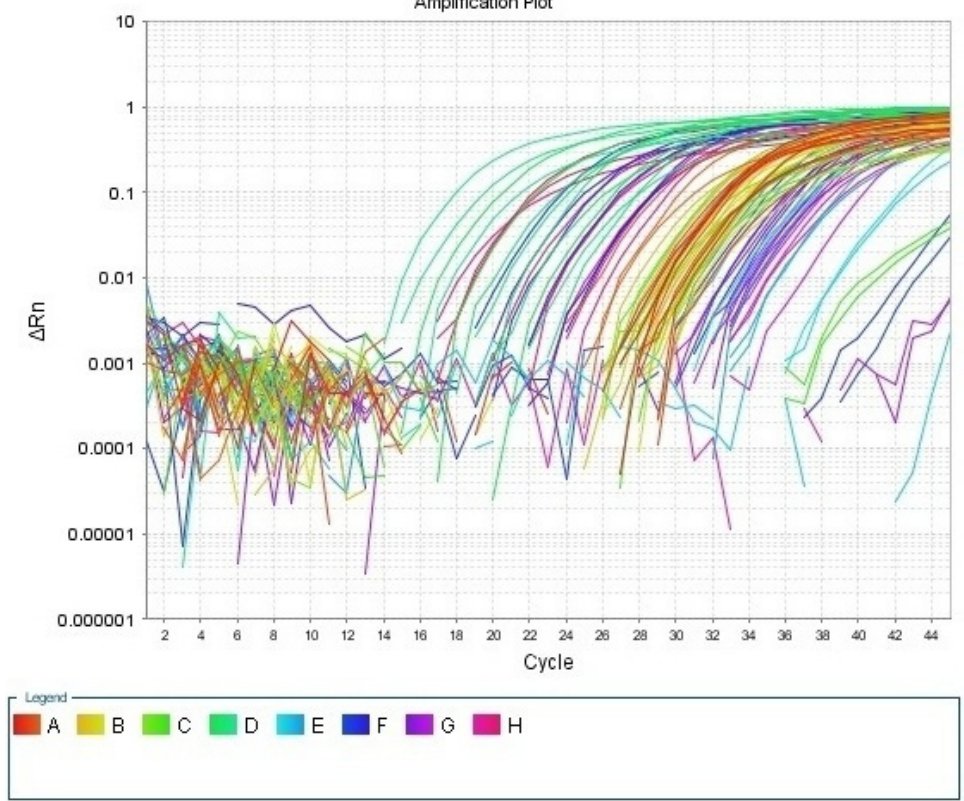
Figure 1. Amplification plot for the first run.